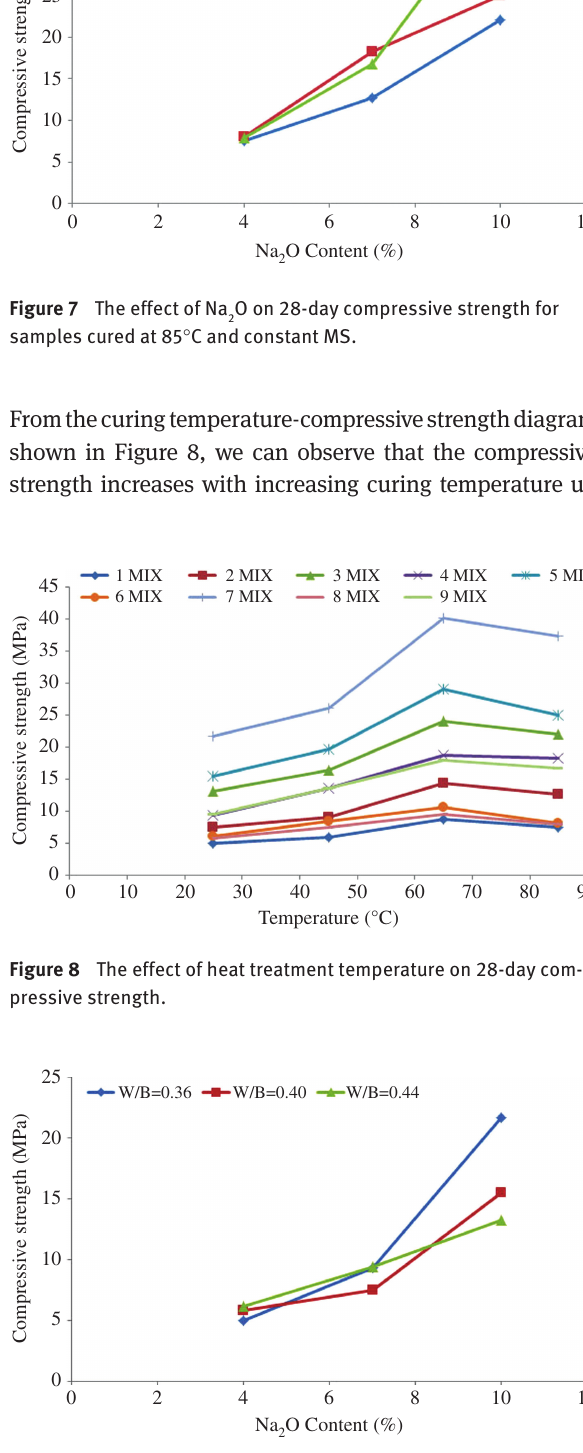
O on 28-day compressive strength for Figure 9 The effect of Na 2 samples cured at 25 ° C and constant